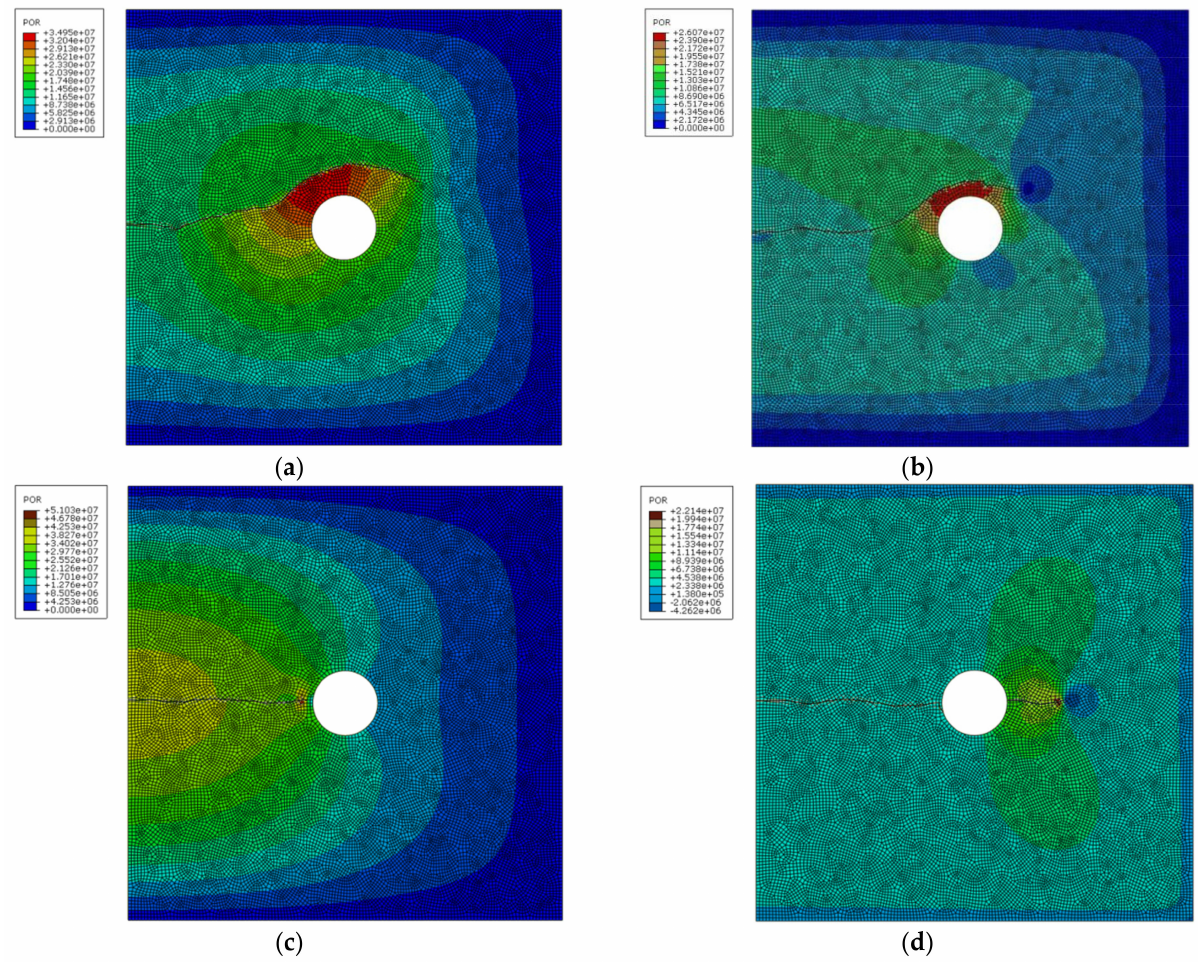
Figure 15. Cloud diagram of fracture propagation under different internal pressures of the vug: ( a ) P = 50 MPa; ( b ) P = 55 MPa; ( c ) P = 60 MPa; and ( d ) P = 65 MPa. (POR is the pore pressure. With the color gradually changing from red to blue, the pore pressure